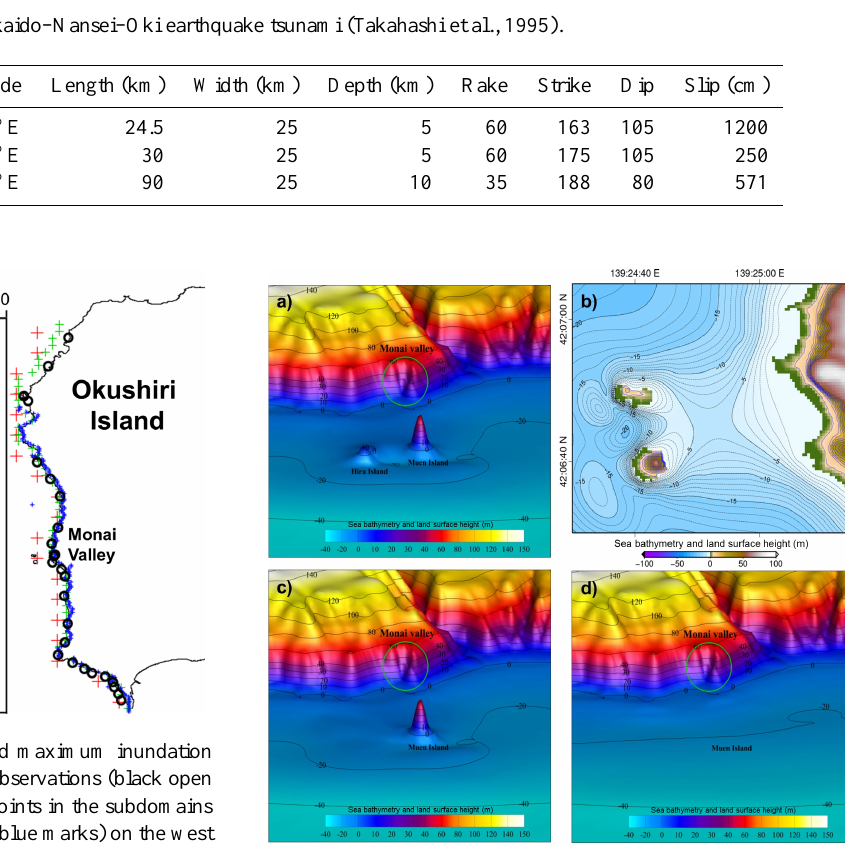
Figure 6. Bathymetry and topography used (a) with two islands ( b is a detailed contour map with two islands), (c) with one island and (d) without